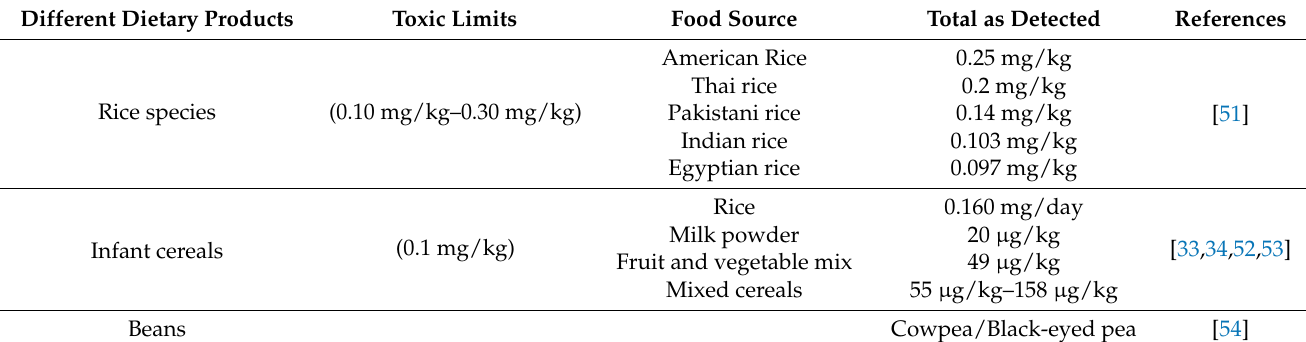
Table 3. Total inorganic arsenic contamination in different foods available in our daily life with their toxic limits and detected